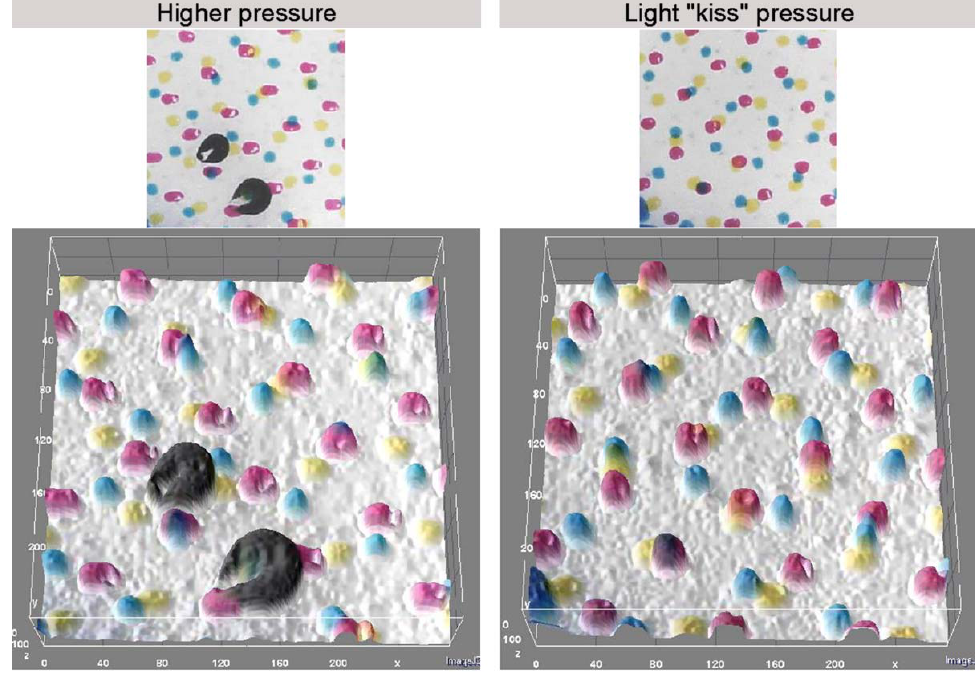
Figure 11. Topographic view of dots at different settings for the printing pressure.